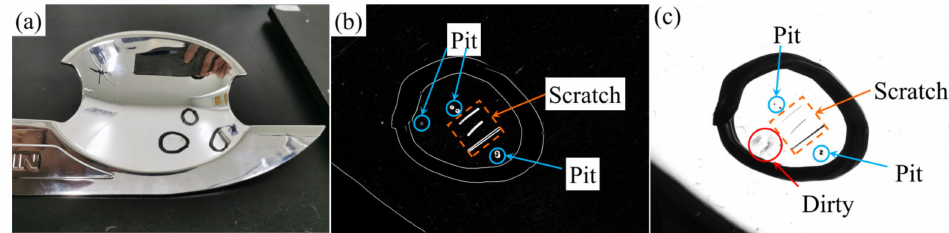
Figure 9. Automobile door bowl ( a ), test results ( b ) and bright field image ( c ).